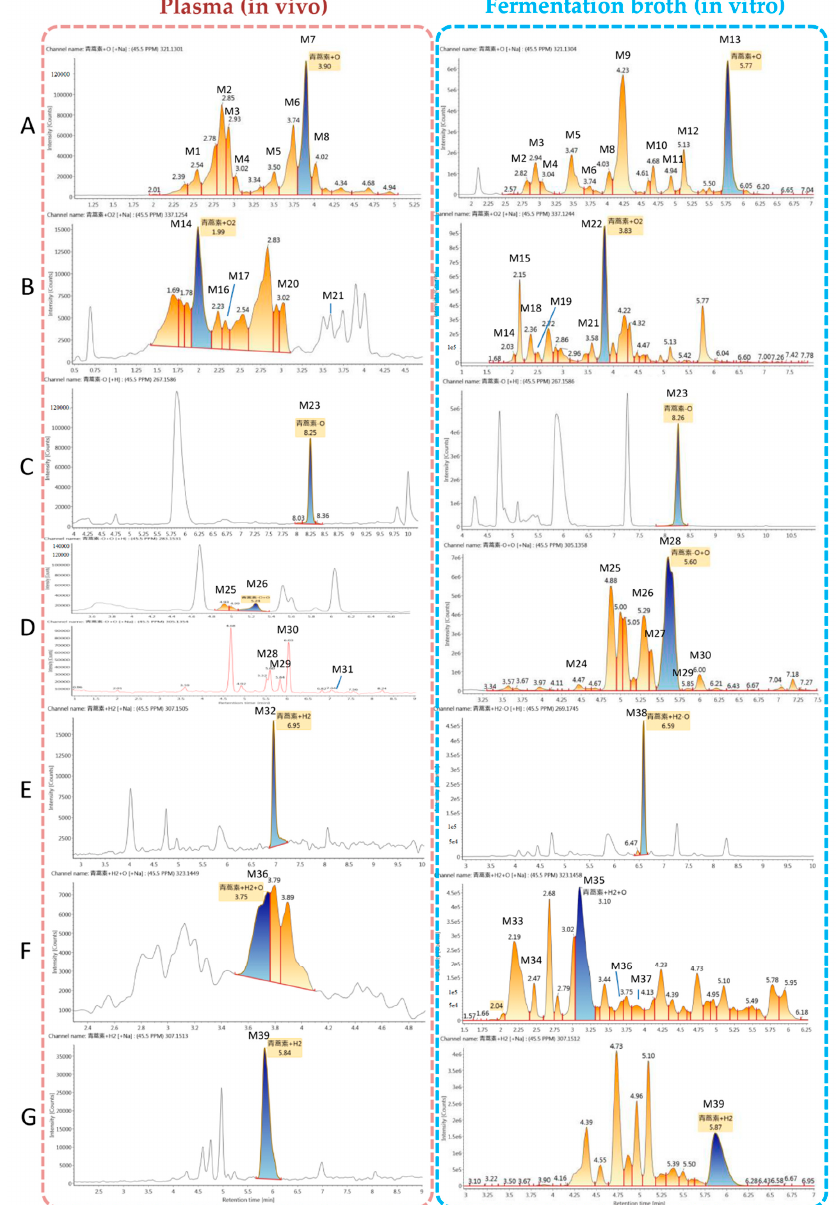
Figure 2. Extracted ion chromatograms of the artemisinin (ART) metabolites obtained from mouse plasma (left) and fermentation broth of C. elegans CICC 40250 (right). ( A ) monohydroxylation metabolites (M1–M13), ( B ) dihydroxylation metabolites (M14–M22), ( C ) deoxyartemisinin (de-ART; M23), ( D ) deoxygenation followed by hydroxylation metabolites (M24–M31), ( E ) dihydroartemisinin (DHA; M32) and deoxygenated DHA (M38), ( F ) hydrogenated DHA (M33–M37), and ( G ) hydrogenation followed by deoxidization of DHA